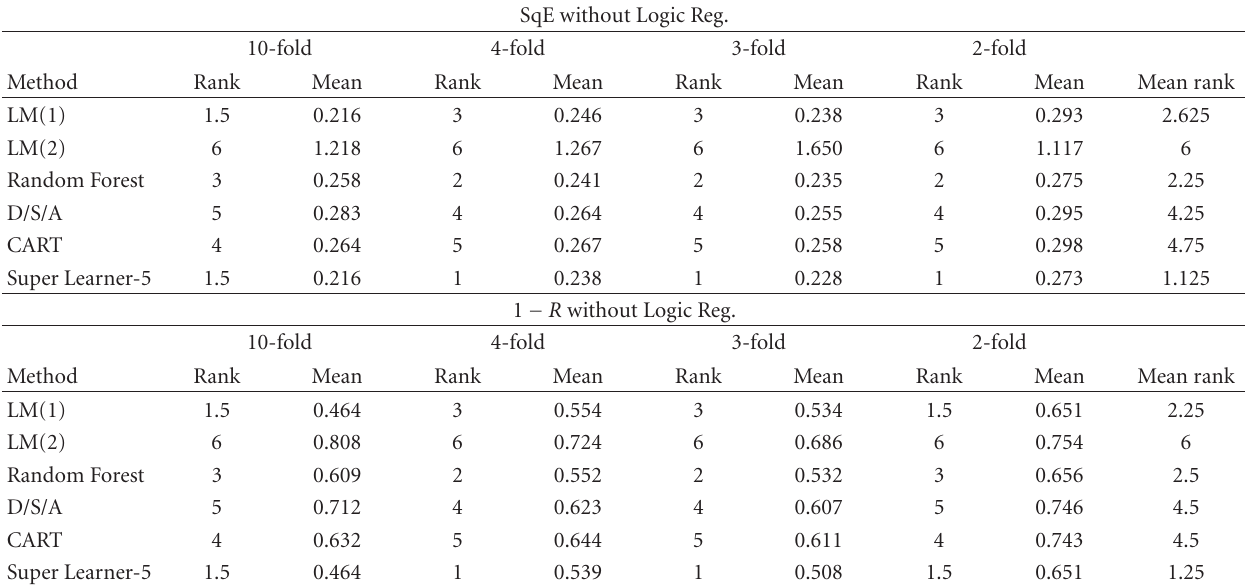
Table 1: Squared error, R detailed values and corresponding rank on Jaguar trial data for 10-fold, 4-fold, 3-fold, and 2-fold. SqE without Logic